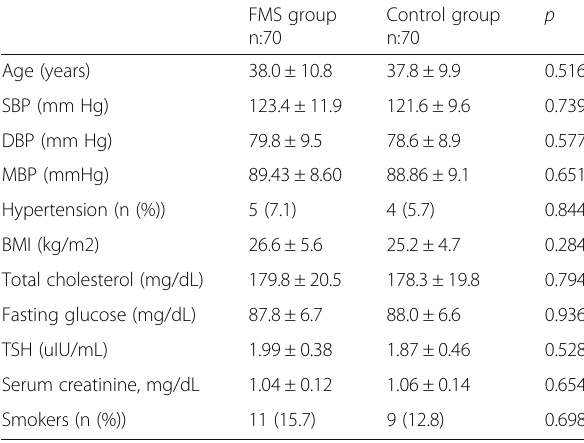
Table 1 The laboratory and clinical features of the FMS and control